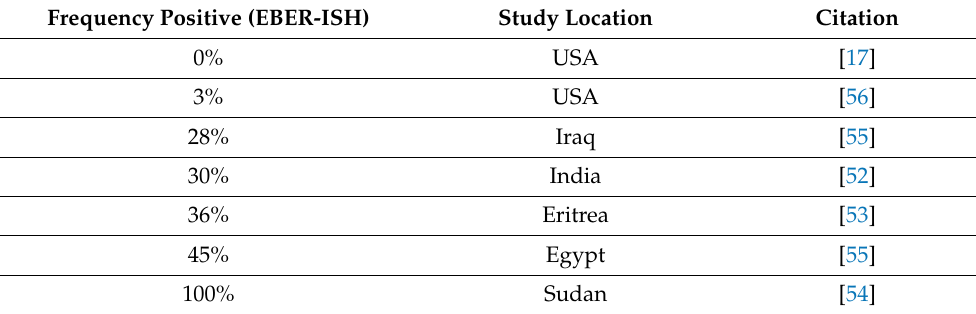
Table 1. Reported association of breast cancer cells with EBV (as detected by EBER-ISH). Frequency Positive (EBER-ISH) Study Location